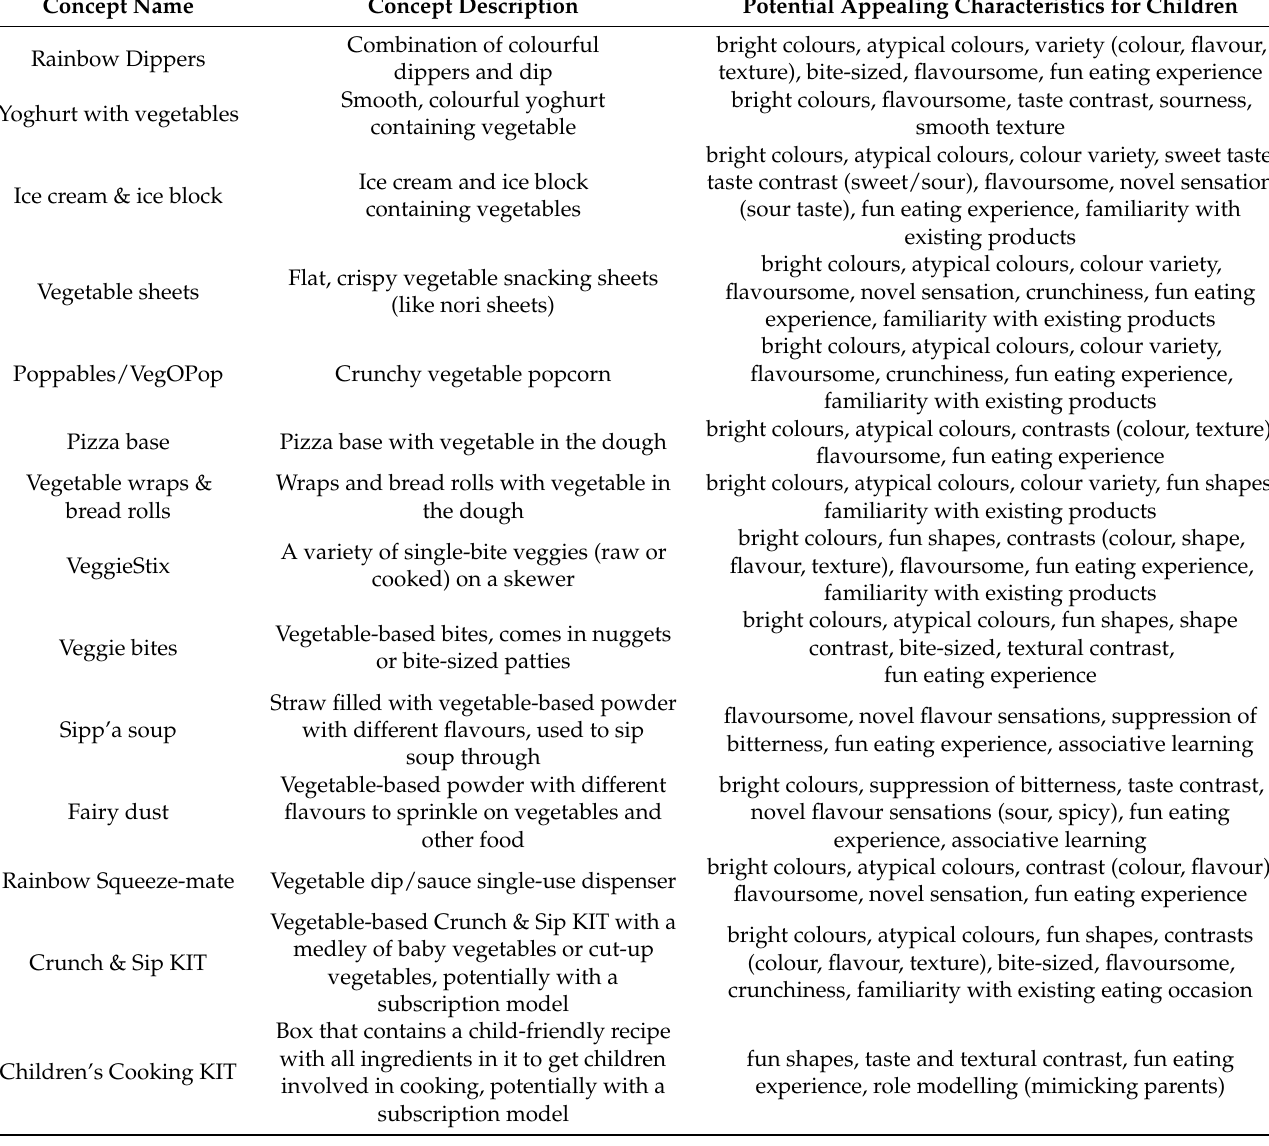
Table 2. Concept name, description, and all potential appealing attributes from the literature and product